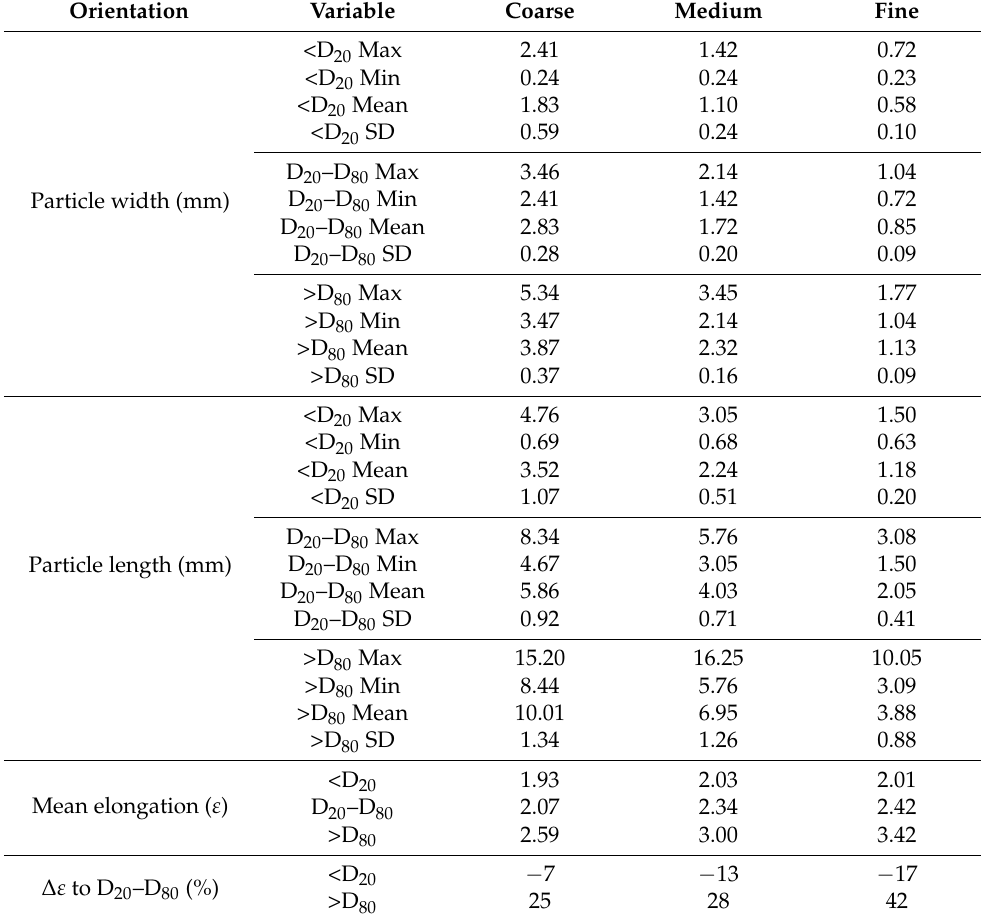
Table 6. Properties of estimated mass particle size distributions (PSD) per range and granulometry.